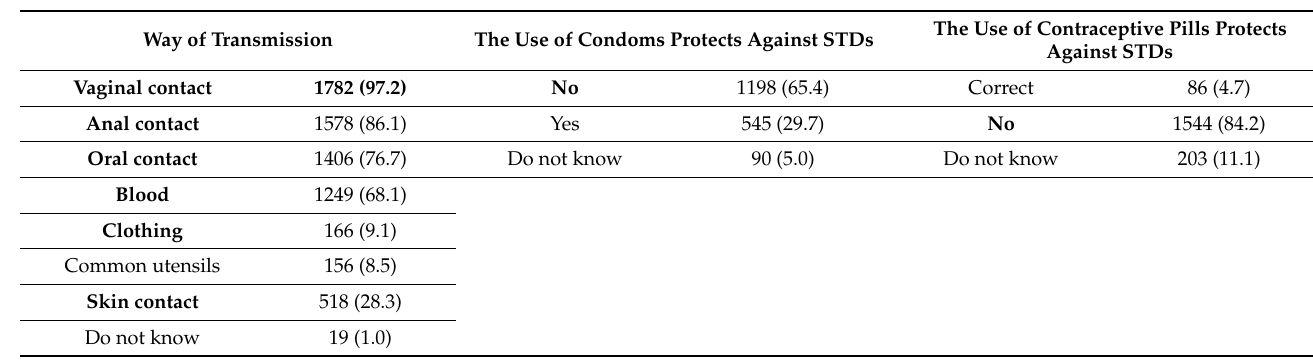
Table 3. Knowledge of the young population regarding STDs and prevention